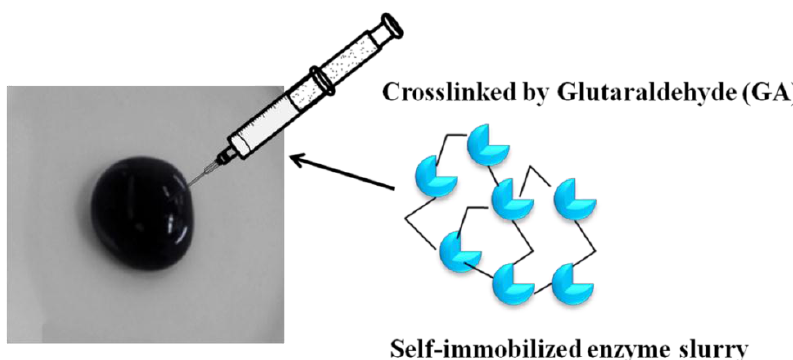
Figure 2. Illustration of the Lac and GOD immobilized on BC/c-MWCNTs by GA crosslinking.